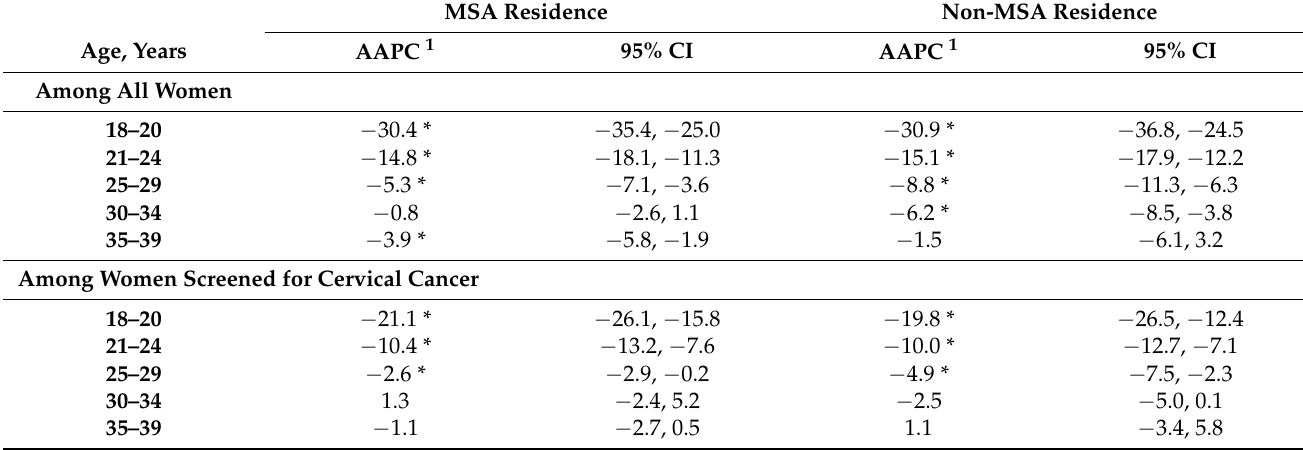
AAPC: average annual percent change; CI: confidence interval; CIN2+: cervical intraepithelial neoplasia grades 2 and 3, and adenocarcinoma in situ; MSA: metropolitan statistical area. 1 Average annual percent changes are weighted averages of annual percent changes from 2008 to 2018. * Asterisks indicate statistical significance ( p < 0.05).